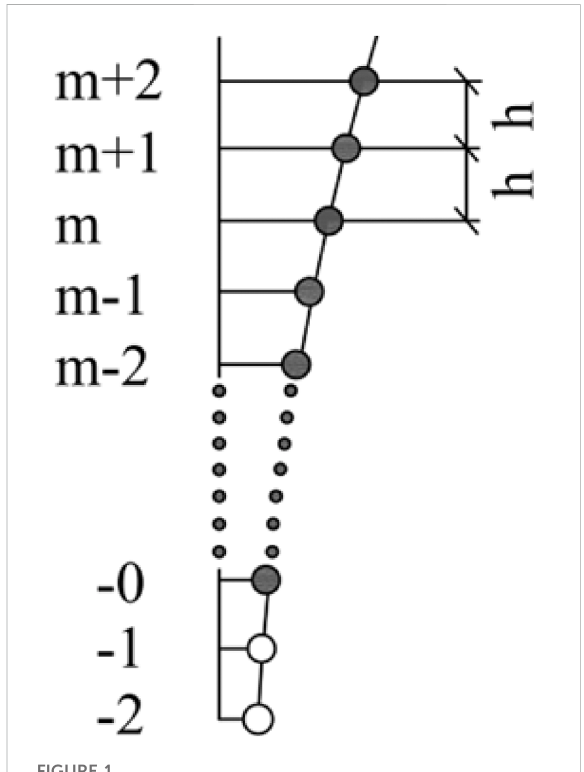
FIGURE 1 Schematic graph of beam